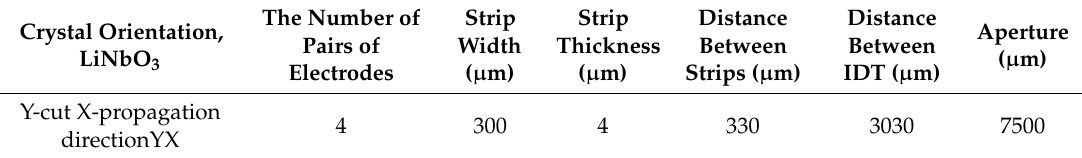
Table 1. Geometricparametersoftheprintinglayoutofthedevelopeddelaylines. IDT:interdigitaltransducers.